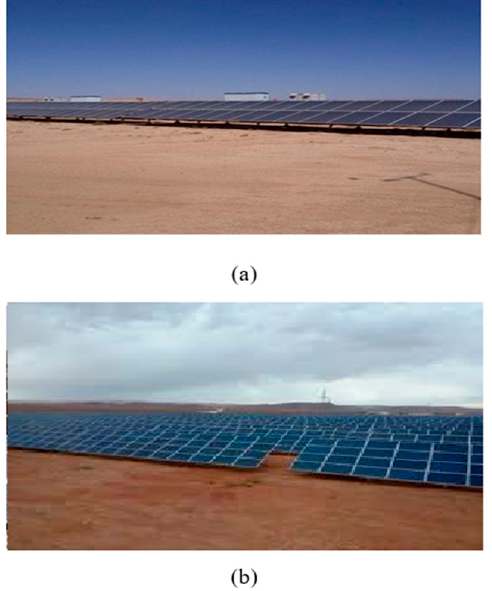
Figure 18. (a ) PV farm in Tamanrasset. ( b ) PV farm in Djelfa. Table 8. PV factory locations in